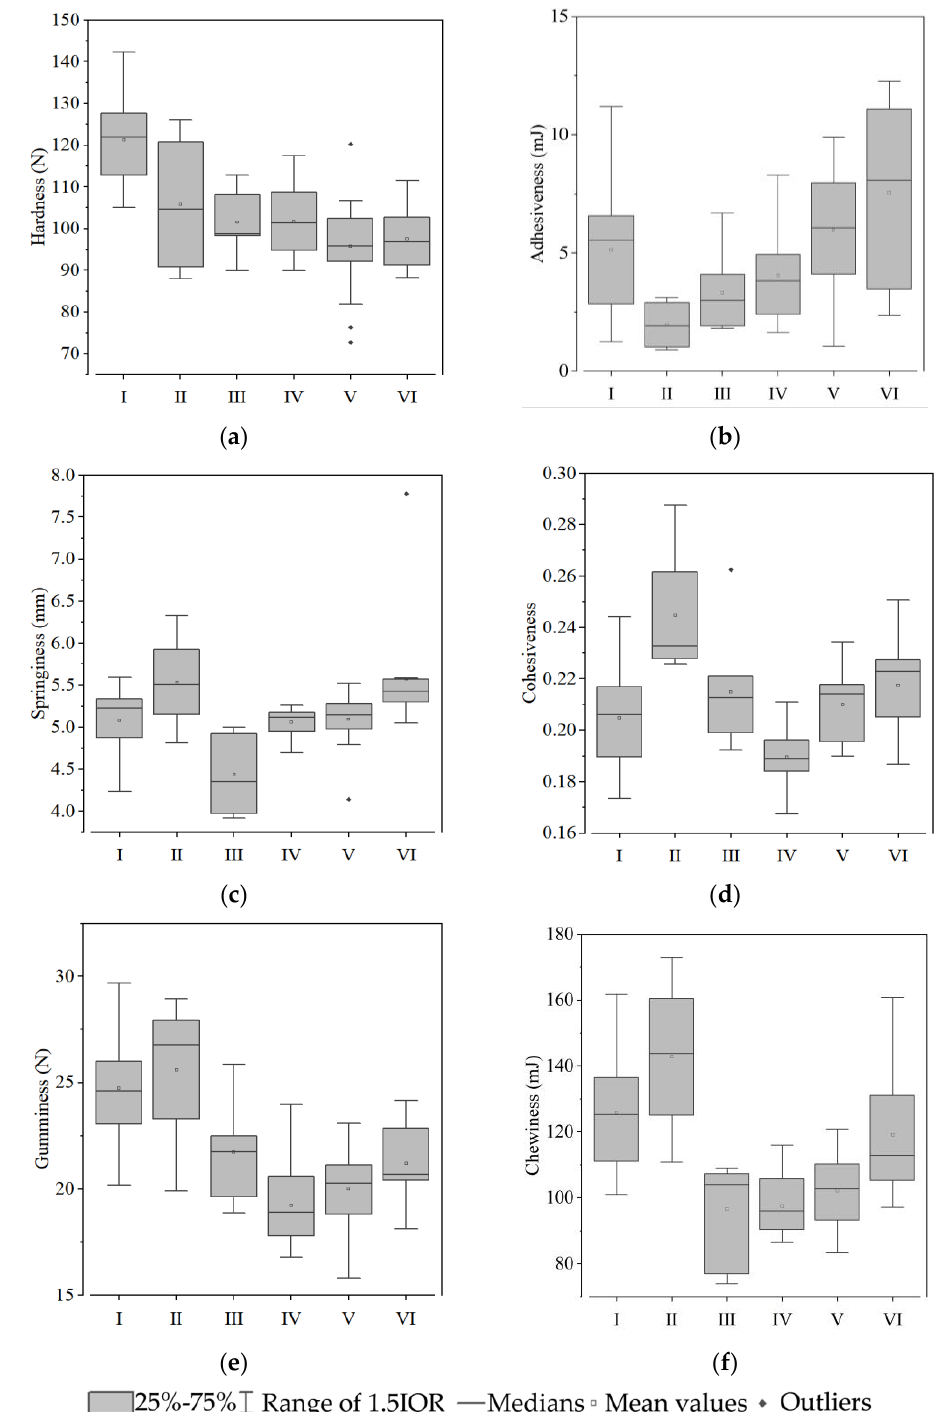
Figure 3. Textural properties of the tuberous roots of six sweet potato characteristics: ( a ) hardness; ( b ) adhesiveness; ( c ) springiness; ( d ) cohesiveness; ( e ) gumminess; and ( f ) chewiness. Hollow squares indicate mean values. Rhombuses indicate outliers.